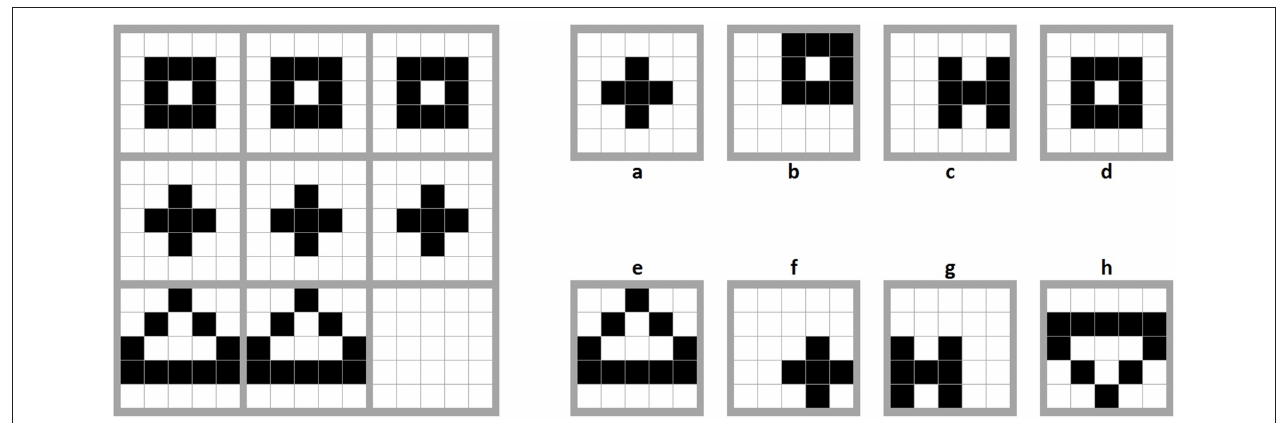
FIGURE 2 | Sample FRM item with MC format. The correct answer was option e